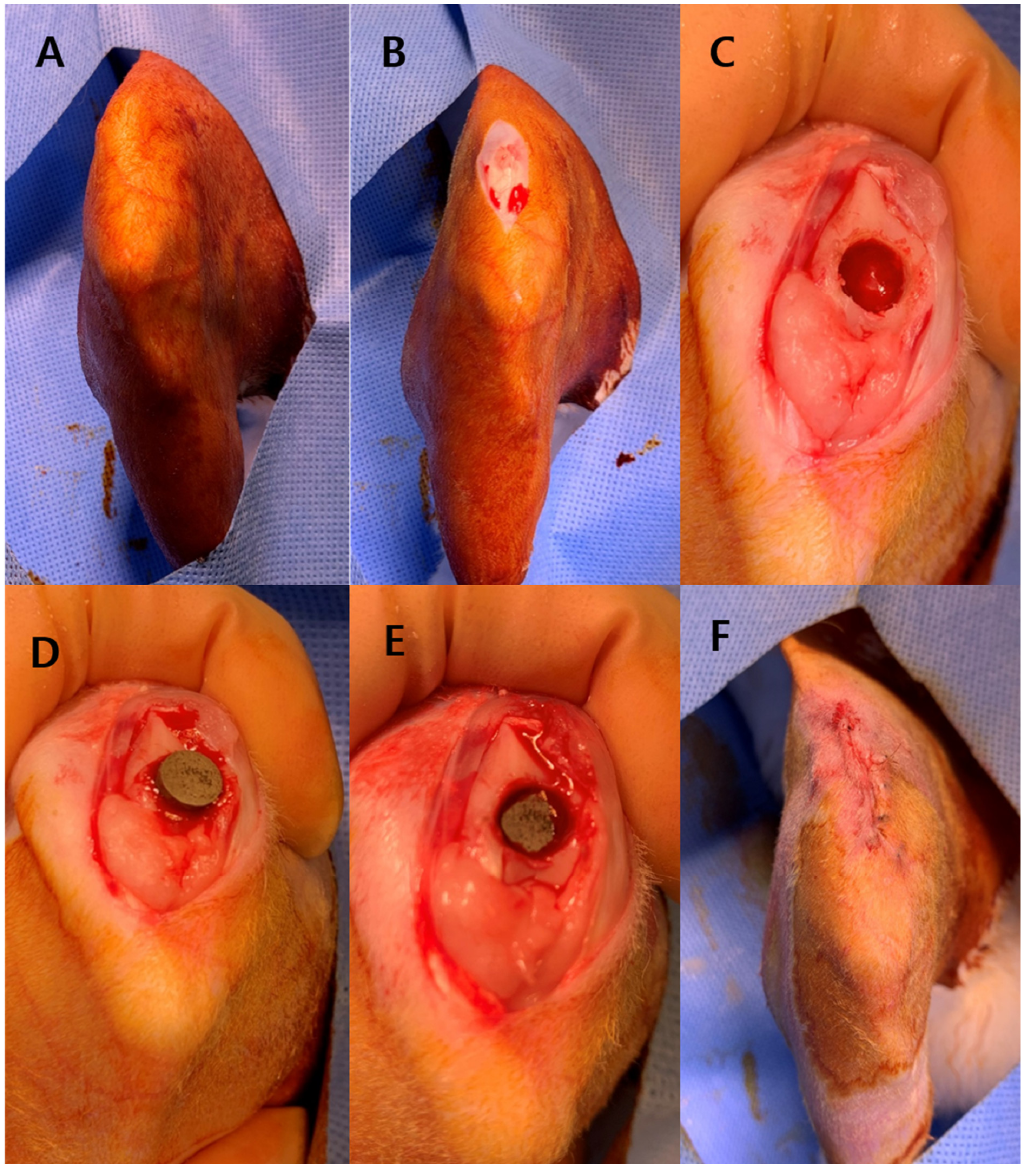
Figure 2. The surgical procedure for implanting specimens into the rabbit trochlear groove. A: The right knee of each rabbit was shaved and sterilized with povidone-iodine. B: In the supine position, the right legs were incised longitudinally from 2 cm above the knee joint to 1.5 cm below the knee joint. C: A hole was created with a 6-mm drill bit in the proximal side of trochlear groove. D: A specimen was placed in the hole with the surface towards the cancellous bone. E: The specimen was gently impacted to contact with the cancellous bone. F: Reduction of the patella and repairing of the incised structure with Vicryl 2–0.